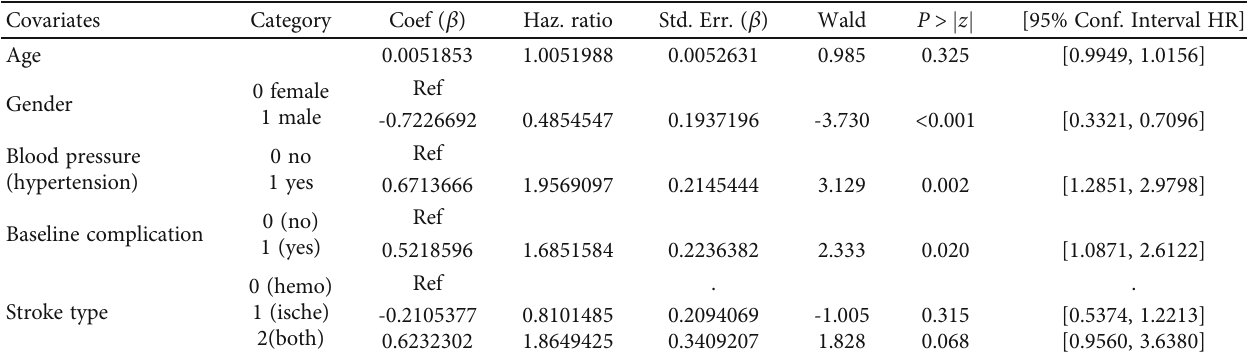
Table 4: Summary multivariable Cox PH analysis to the stroke data set from the